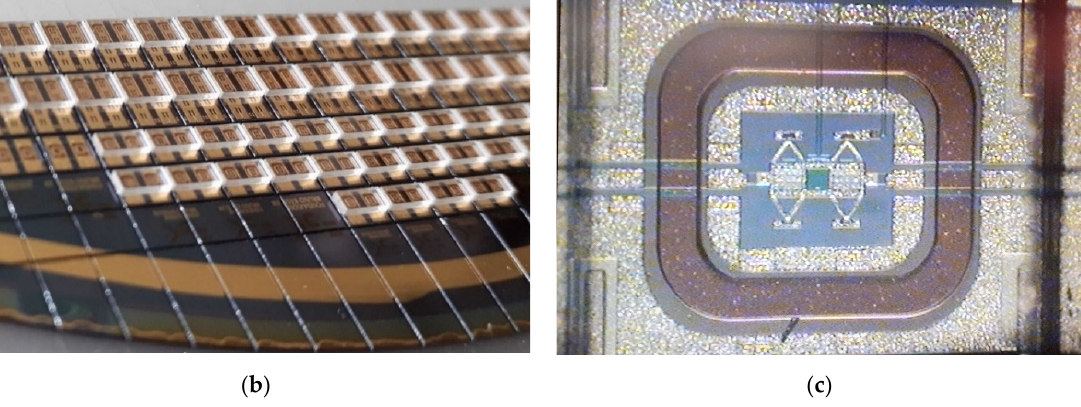
Figure 5. RF ‐ MEMS switch dicing. ( a ) Dicing process schematic. ( b ) Picture of the fabricated wafer showing the RF ‐ MEMS switches with wafer ‐ level encapsulation; a single cap is used for every two switches. ( c ) Picture of a DDG ‐ W fabricated device showing detail of CPW access lines, polysilicon bias lines, sealing ring and quartz cap.